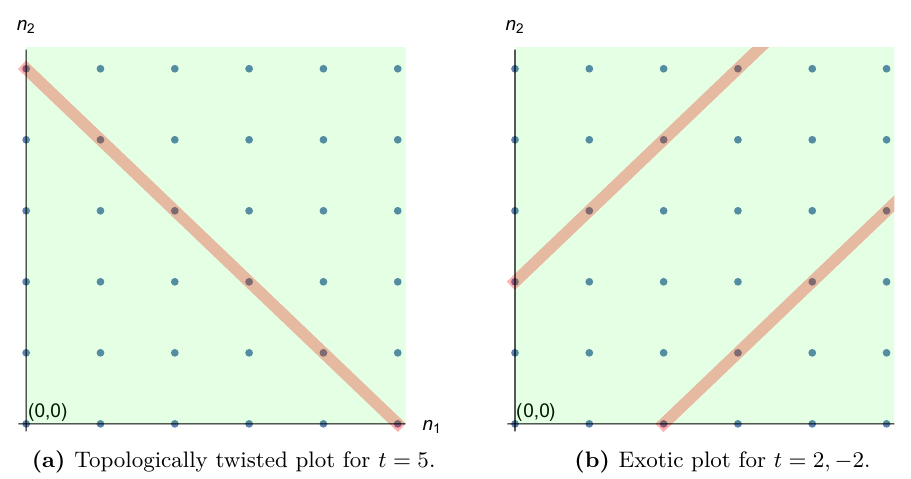
Figure 1 . We plot slices at different values of t = α ( m ) of the quadrant of R 2 spanned by positive ( n ) such that n = ∓ ( n ) . The orientation of the line is related to the choice of fiber used 1 , n 2 1 2 − t to